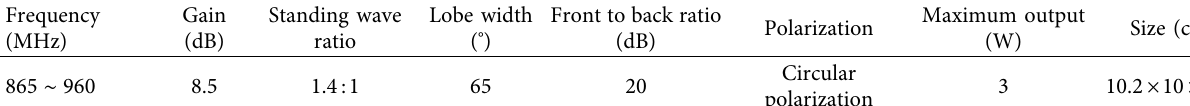
Table 2: S8658 antenna parameters.